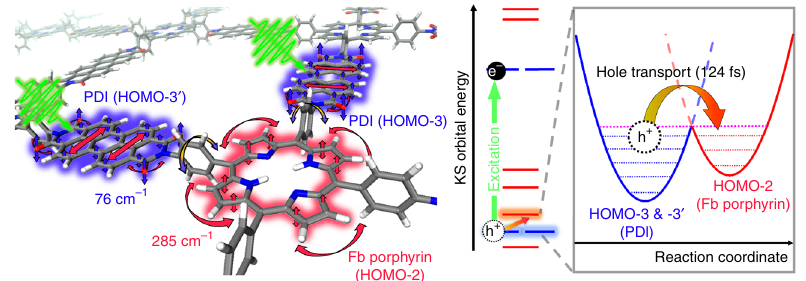
Fig. 5 Schematic of charge carrier dynamics in photoinduced COFs. Upon photoexcitation of COFs, ultrafast hole transfer through the splitting of excitons occurs from PDI to free-base porphyrin (Fb porphyrin) unit with the time constant of 124 fs. According to the NA-MD simulation, the quasi-degenerate electronic states of HOMO-3 (or -3 ′ ) and HOMO-2 facilitate such ultrafast transfer of charge carriers. The coherent oscillations with the frequencies of 76 cm − 1 and 285 cm − 1 superimposed on the decay of TA spectra are associated with coherent lattice phonons of COFs. Especially, the change in the dihedral angle of benzene linker (yellow arrow) can be related with the motions that enhance π -interaction between PDI and porphyrin units, resulting